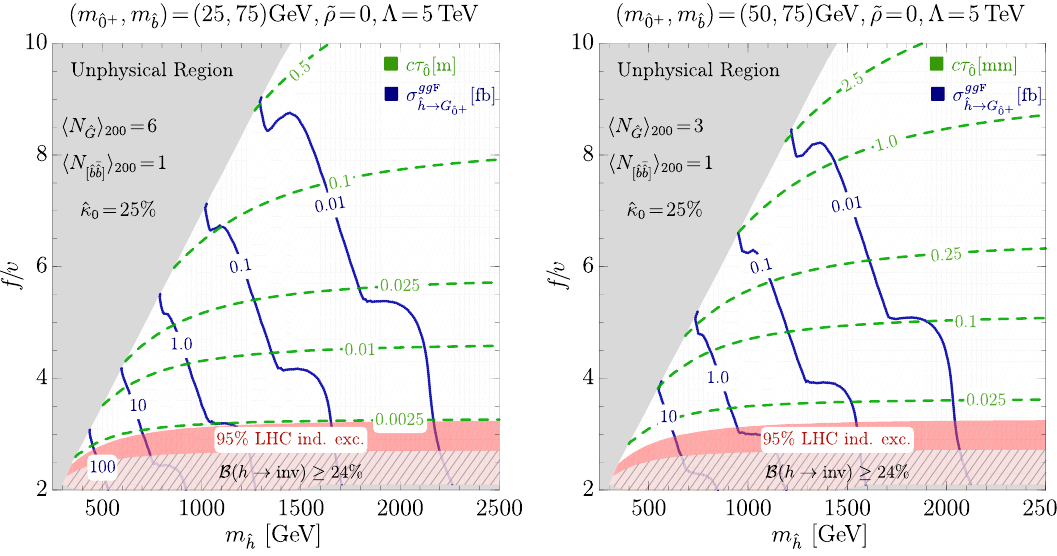
Figure 13 . These graphs show the contours of production cross-sections (solid blue) and proper decay-lengths (dashed green) of twin glueball ^ G and right-panel, respectively, with m ^